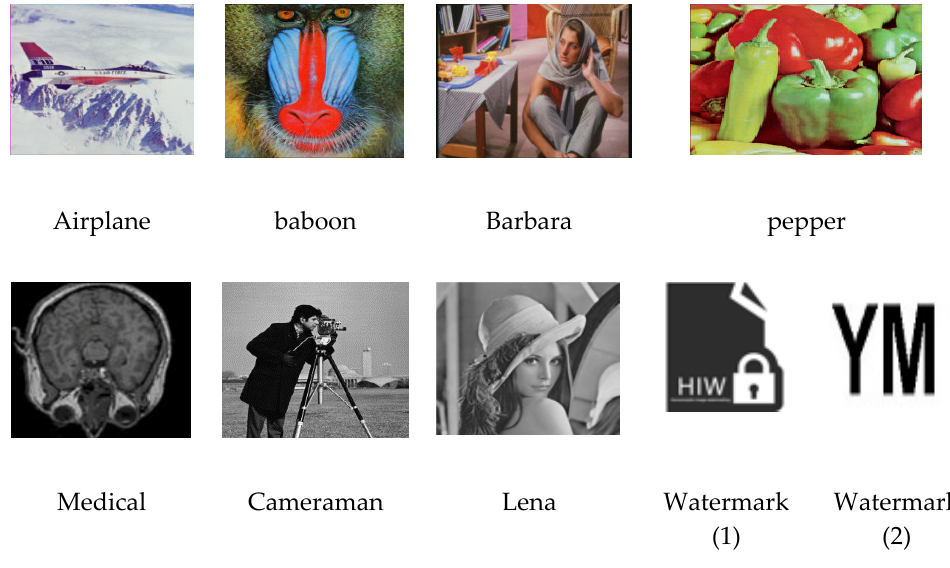
Figure 6. Color, grayscale and medical images and